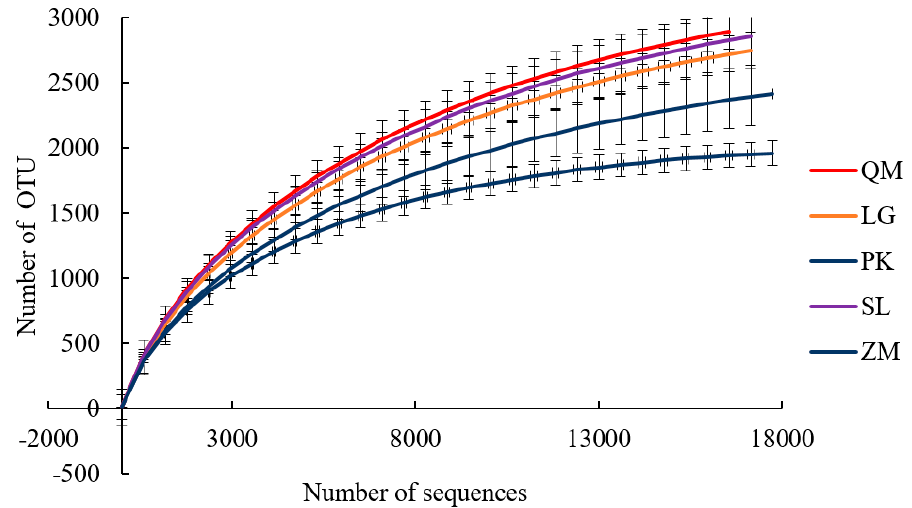
Figure 1. Rarefaction curves of 16S rDNA for high throughput sequencing of bacteria from soils with different land use types. QM: Quercus mongolica ; LG: Larix gmelinii ; PK: Pinus koraiensis ; SL: Shrubland; ZM: Zea mays .